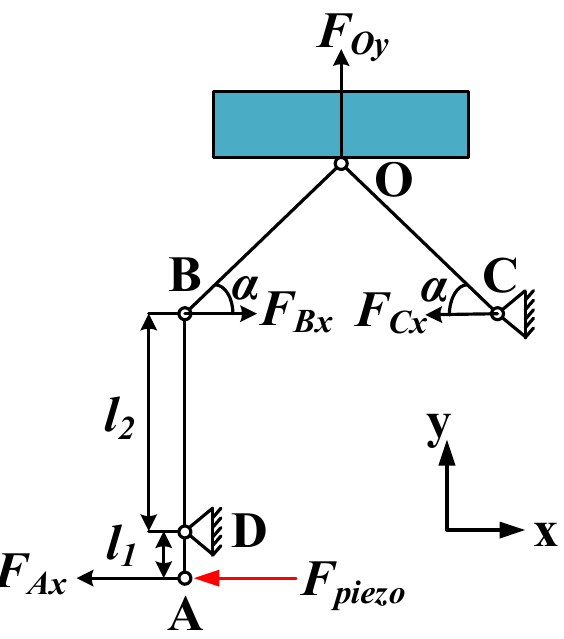
Figure 10. Force analysis of the PEA.